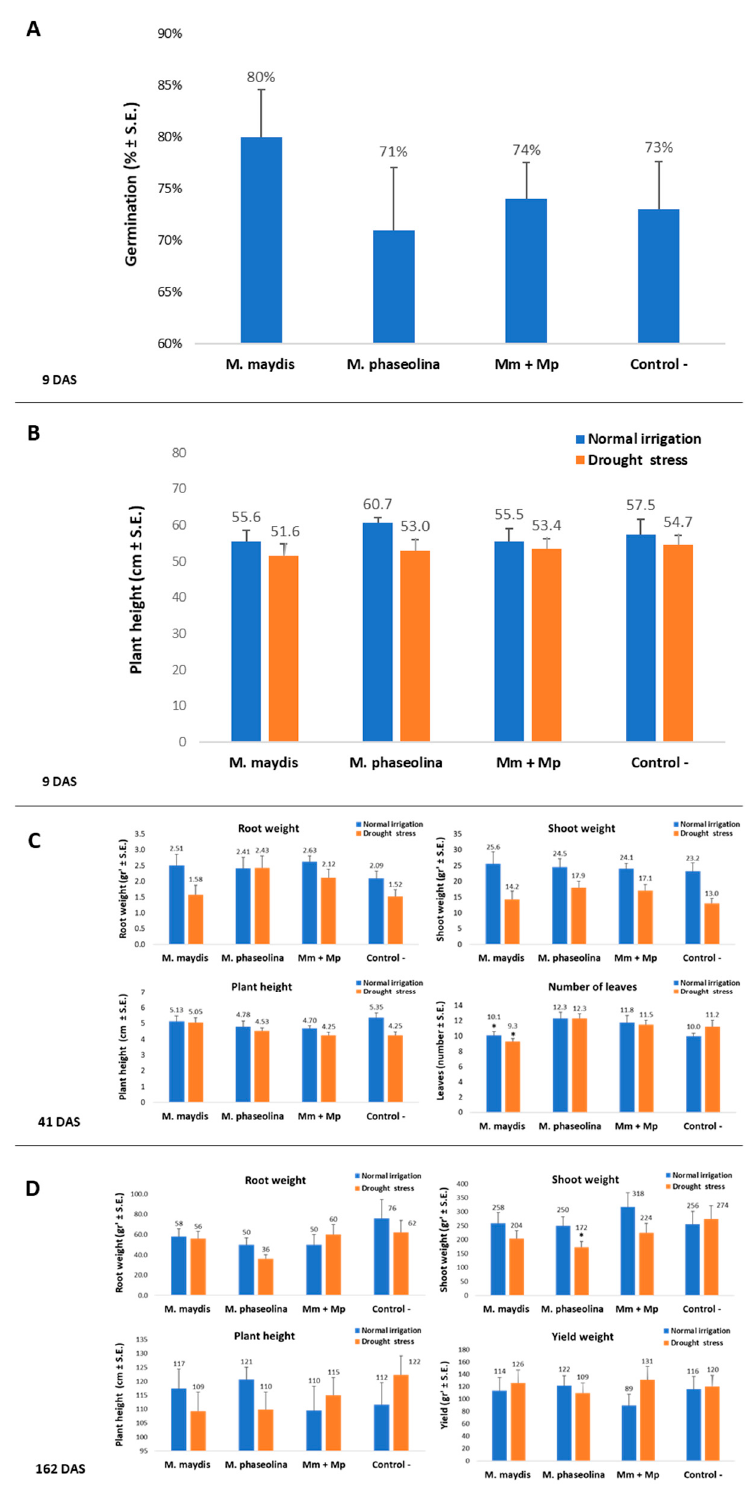
Figure 9. Symptoms evaluation and yield assessment in cotton. Plant developmental values and yield assessment was made for plants in the 2019 experiment described in Figure 7. Sprout emergence ( A ) and height, ( B ) 9 DAS, phenological development, 41 DAS ( C ), and growth and yield assessment, 162 DAS ( D ), were determined after the inoculation of the plants with M. maydis and M. phaseolina , alone or in mixed inoculation. Vertical upper bars represent the standard error of the mean of 10 replications (pots, each containing one plant 41 DAS onwards). When existing, significance from the control (untreated) is indicated as * = p <